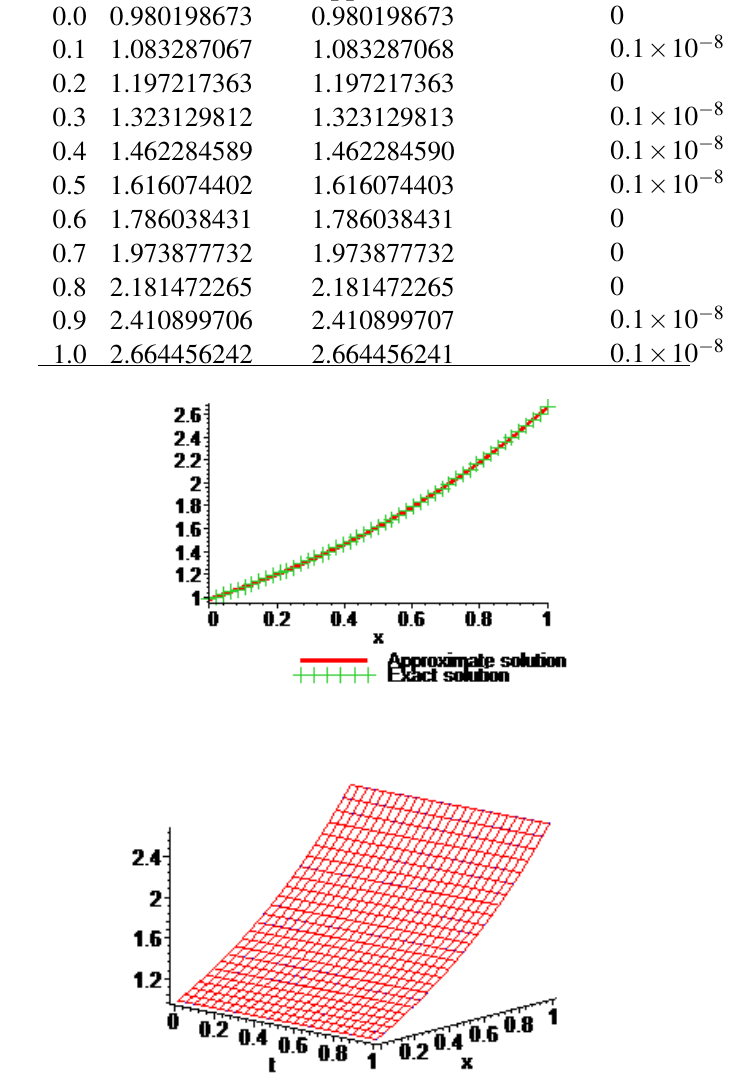
Fig. 3 Comparison of exact and approximate solutions for Example